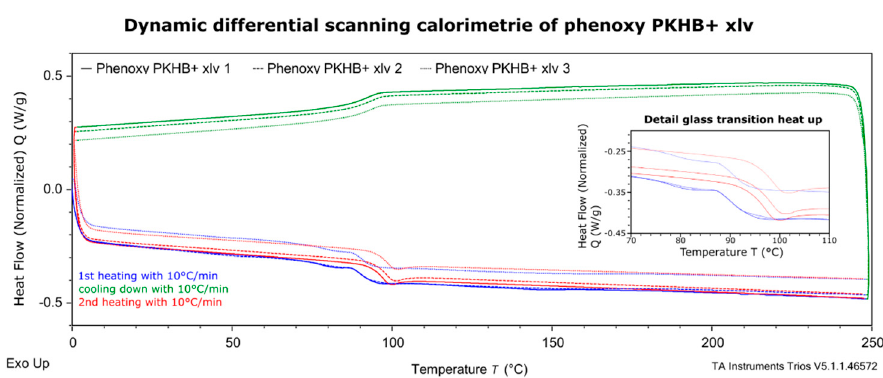
Figure 2. Dynamic differential scanning calorimetry (DSC) curve for the determination of the glass transition temperature. Blue: first heating, red: second heating and green cooling.